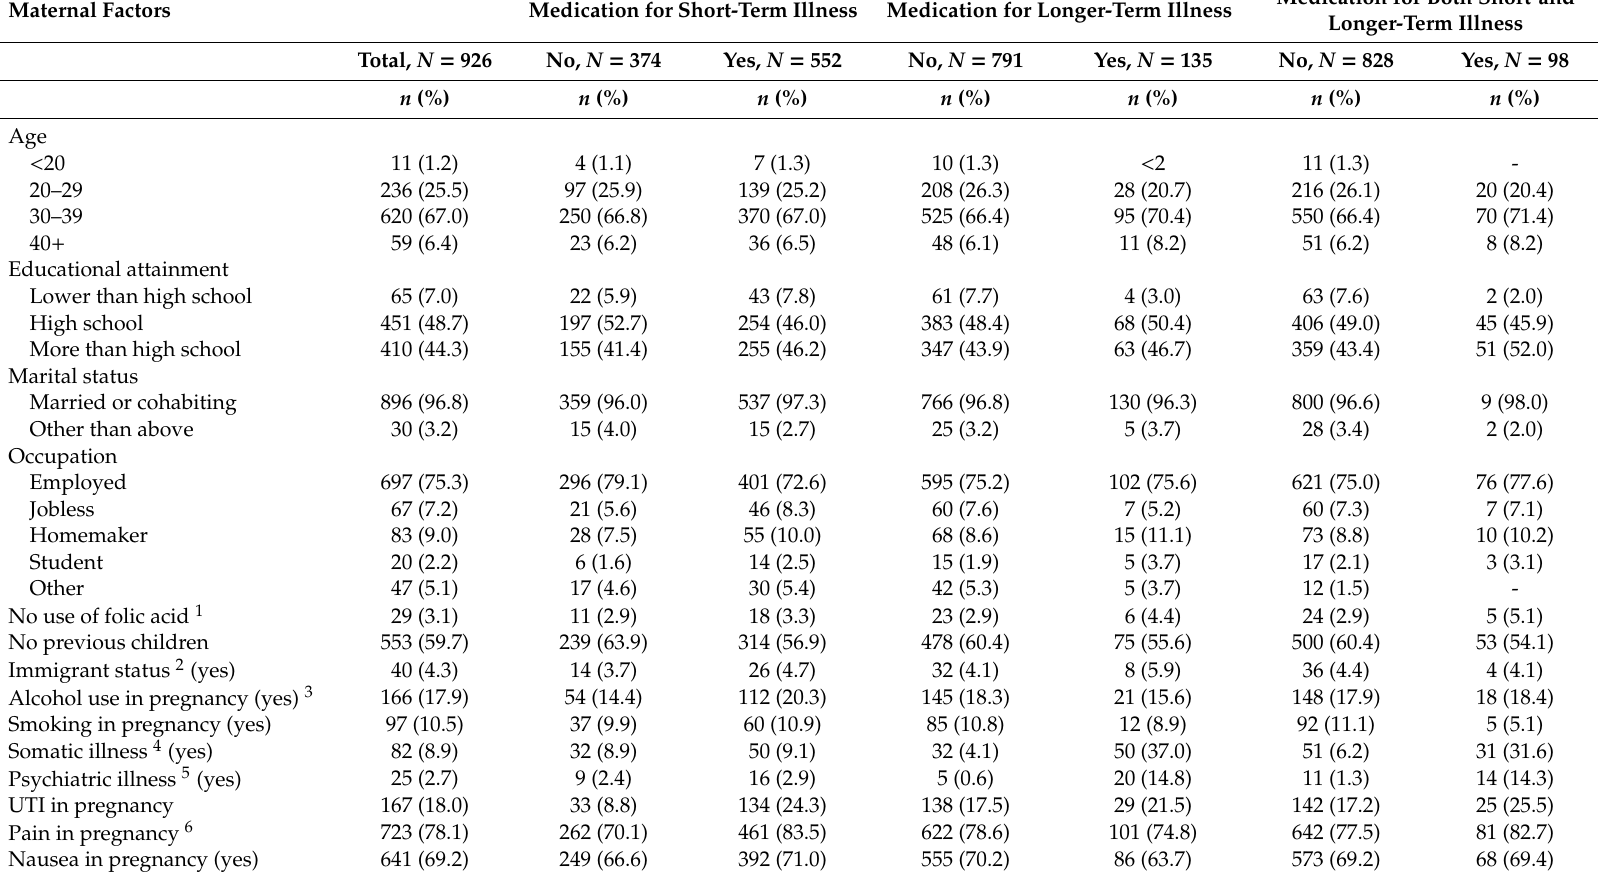
1 The table shows crude, non-weighted proportions. Abbreviations: UTI = urinary tract infection. 1 Indicates use of folate before and / or during pregnancy. 2 Women having the first language di ff erent from Italian. 3 Indicates alcohol consumption after awareness of the pregnancy. 4 Includes asthma, allergy, cardiovascular and rheumatic diseases, epilepsy and diabetes type I or II. 5 Includes anxiety and depression. 6 Includes headache, pelvic or neck or back pains. Numbers may not add up to total due to missing values; missing value were 5 (0.5%) for smoking, 12 (1.3%) for alcohol use, 3 (0.3%) for immigrant status, 9 (1.0%) for folic acid use, and 12 (1.3%) for